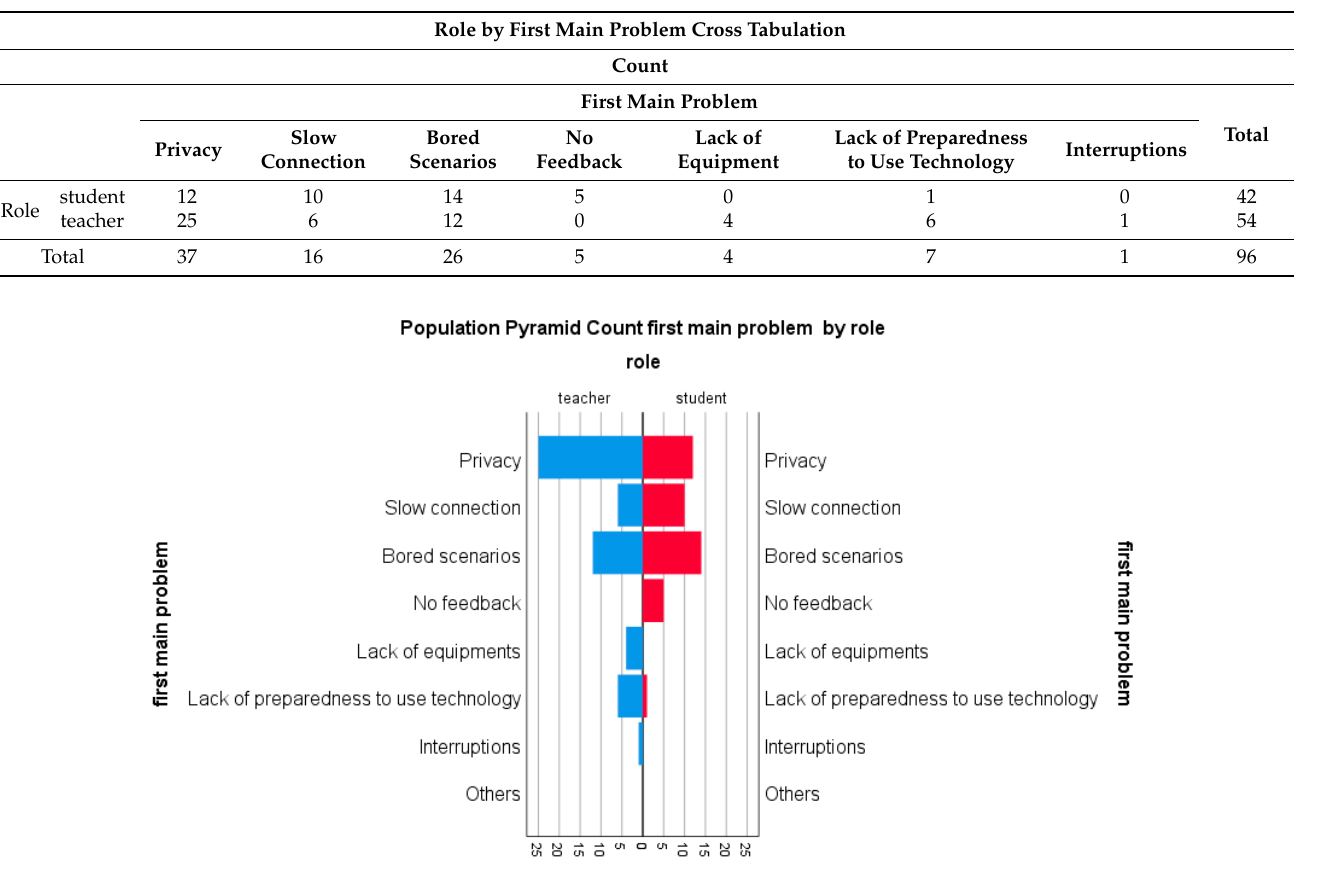
Table 2. Contingency table for variables role and first main problem